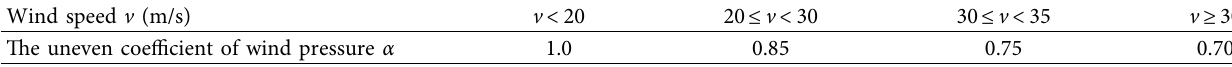
Table 1: Te value of α under diferent wind speeds.